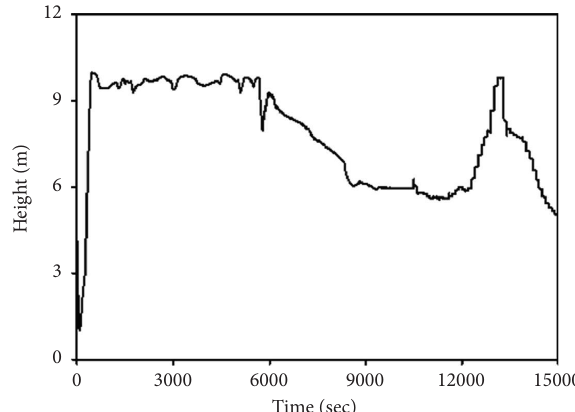
Figure 6: CINEMA results on collapsed water level in pressurizer of the TMI-2 severe